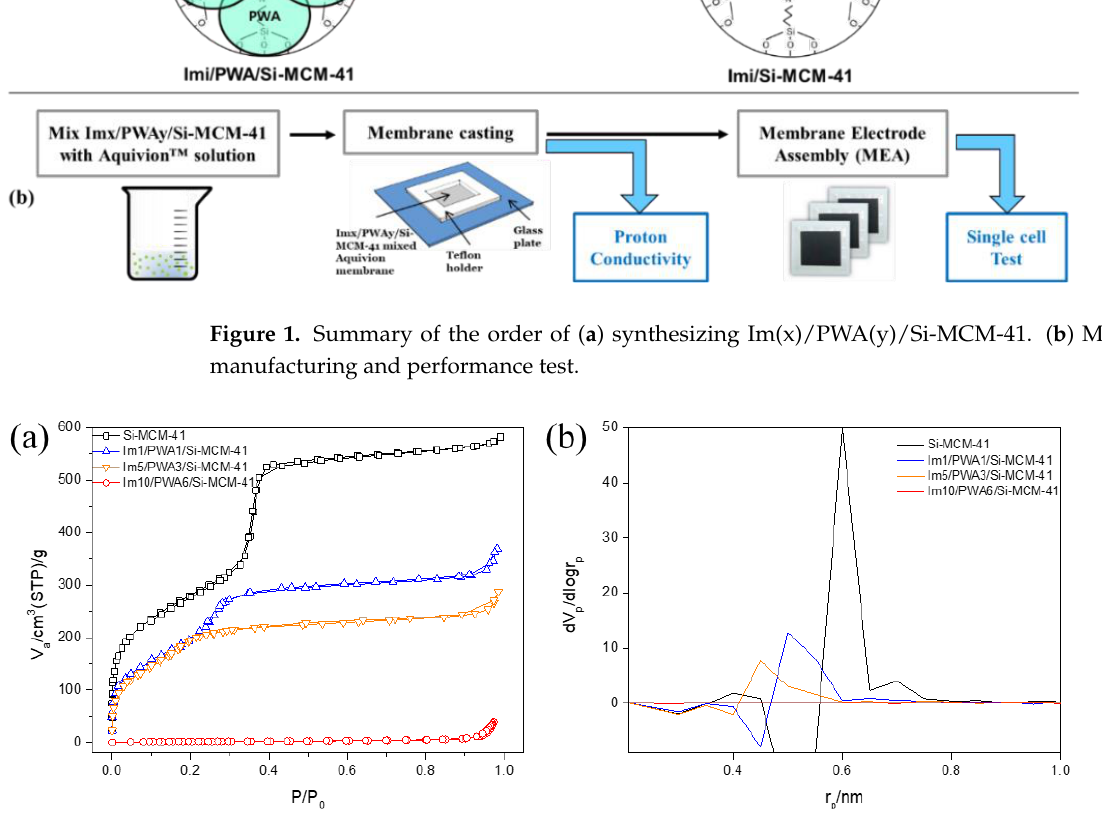
Figure 1. Summary of the order of ( a ) synthesizing Im(x)/PWA(y)/Si-MCM-41. ( b ) Membrane man- ufacturing and performance test.